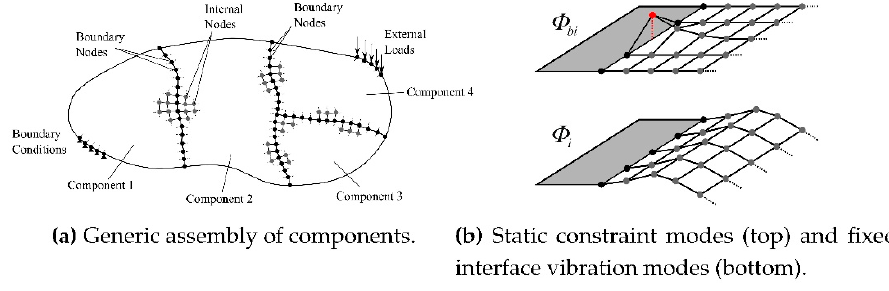
Figure 1. Component mode